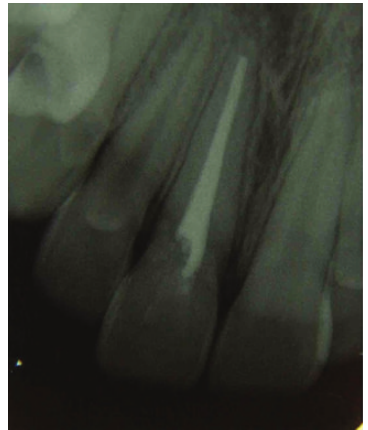
Figure 3: Radiograph after endodontic treatment.